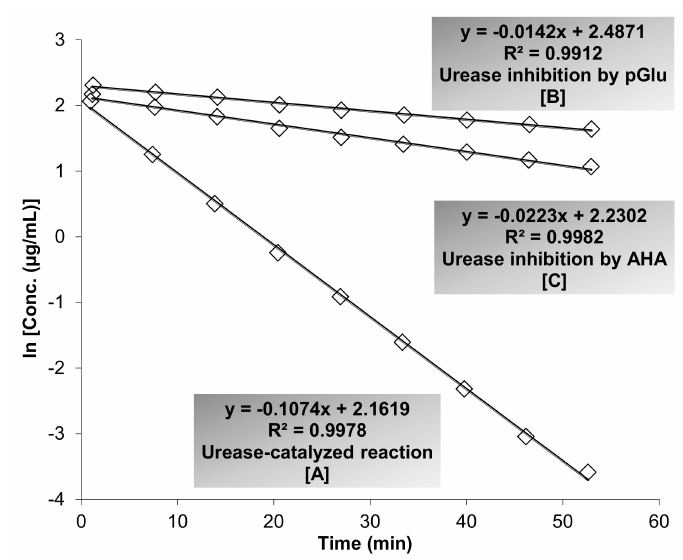
Figure 1. The Electrospray Ionization-Mass Spectrometry (ESI-MS) based method was employed to